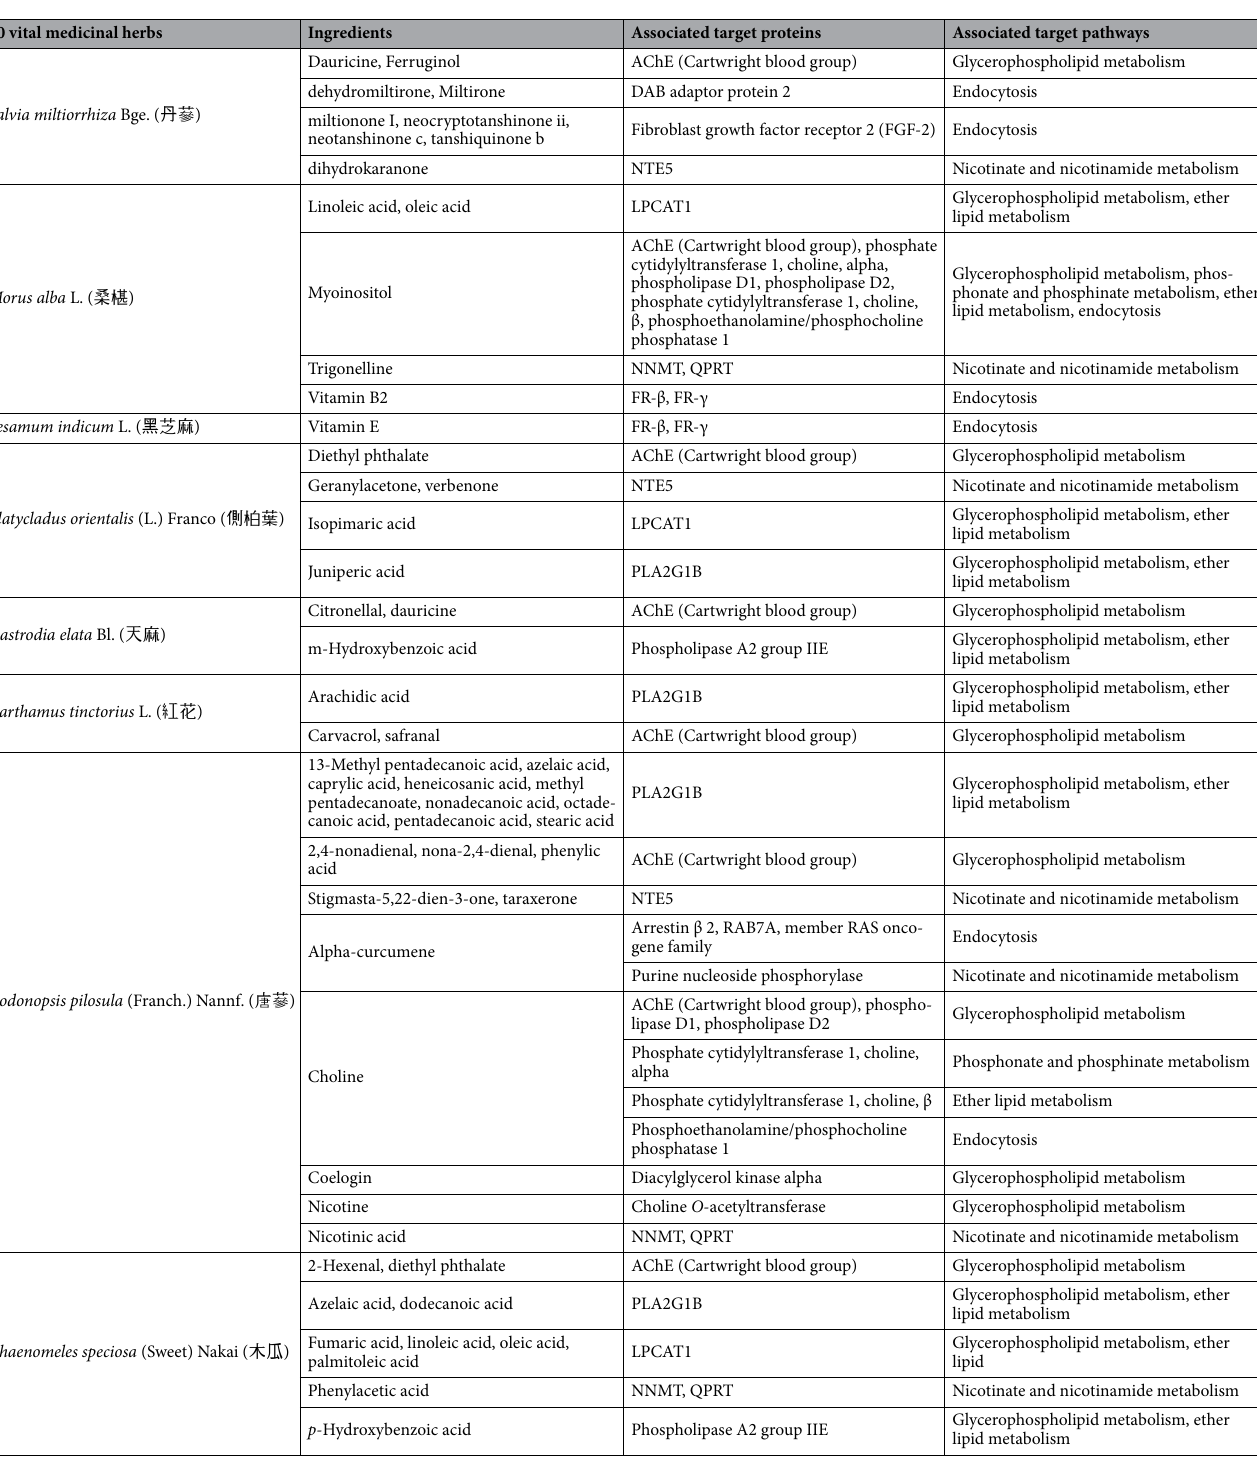
Table 2. List of 20 vital medicinal herb–ingredient–associated protein–associated